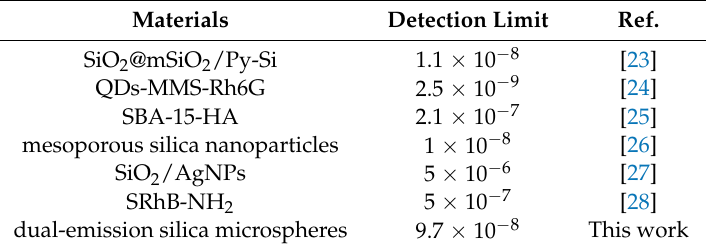
Table 1. Comparison among silica-based sensors for detection of Hg 2+